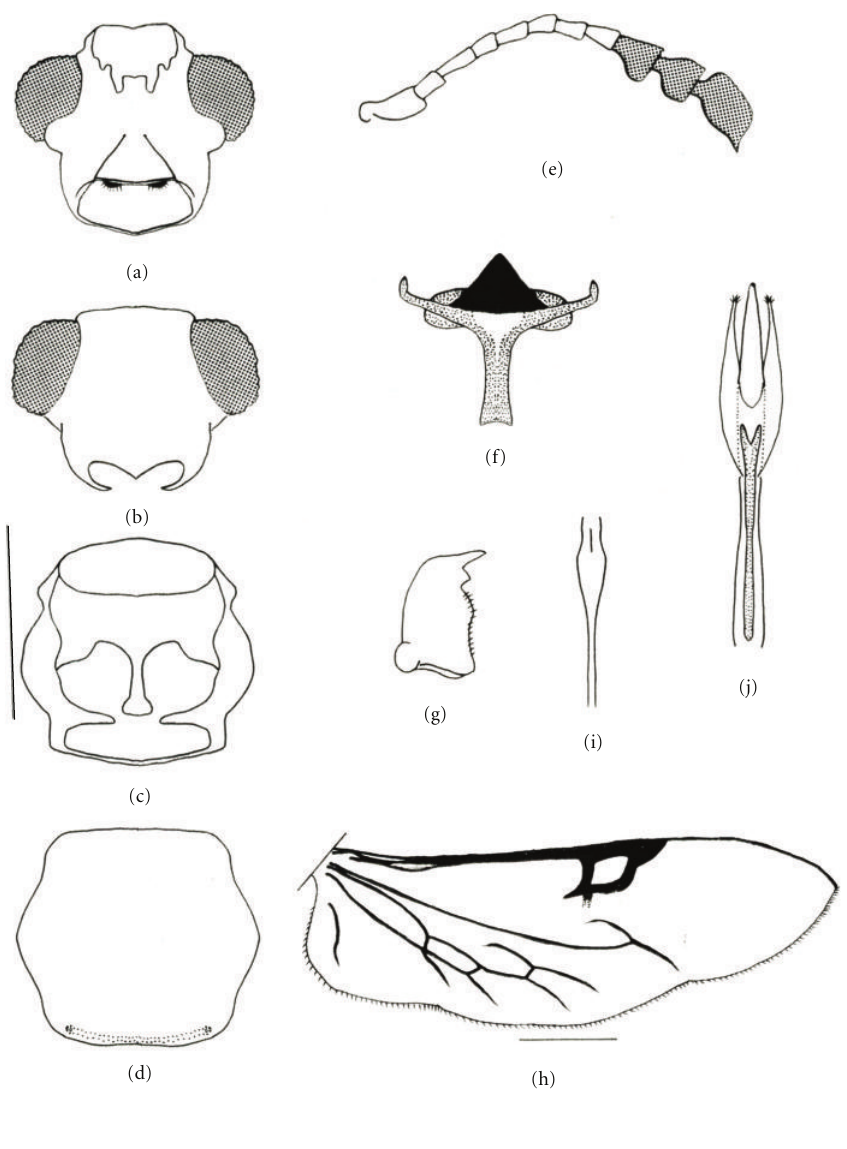
Figure 8: Various organs of Fallopylus pallipes . (a, b) Head ((a) ventral, (b) dorsal). (c, d) Pronotum ((c) ventral, (d) dorsal). (e) Antenna. (f) Metendosternite. (g) Mandible. (h) Metathoracic wing. (i) Spiculum. (j) Aedeagus. mesodermal internal reproductive organs (Figure 11(l)): sac- cular bursa copulatrix present, bursa with two basal sclerites, only apex of spermathecal capsule sclerotized, spermathecal gland attached to apex of